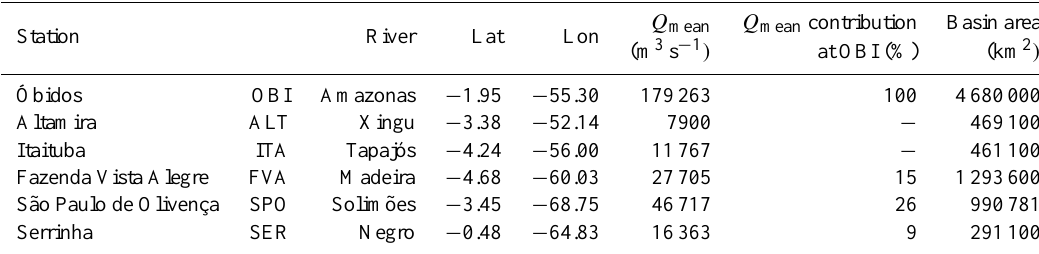
Table 3. List of ORE HYBAM gauging stations over the Amazon Basin. Q mean is the mean annual discharge from ORE HYBAM data, averaged over the period